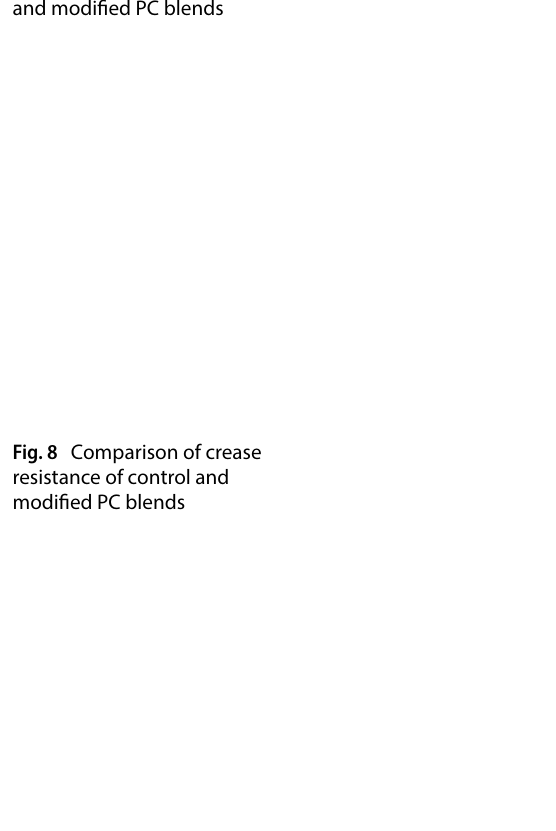
Fig. 7 TG curve of PC blends and modified PC blends